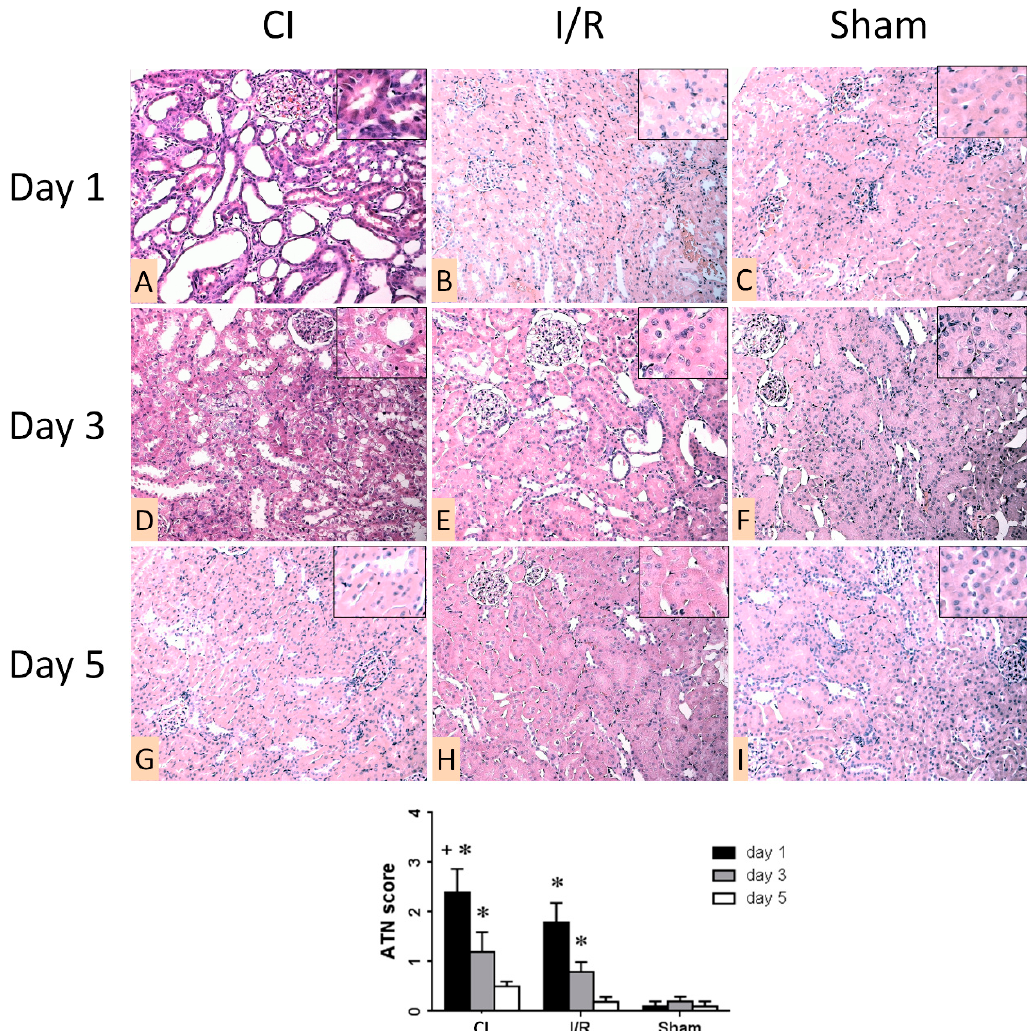
Figure 2. Representative morphologic images of operated left kidneys one ( A – C ), three ( D – F ), and five ( G – I ) days after the operation. First column ( A , D , G ): cold ischemia (CI). Second column ( B , E , H ): ischemia-reperfusion (I/R). Third column ( C , F , I ): sham. (hematoxylin–eosin (HE) staining, 200 × ). Inserts show proximal tubular damage (1000 × ). Graph: quantitative evaluation of acute tubular necrosis (ATN) score 1, 3 and 5 days after the operation (n = 8 in all groups). *: p < 0.01 vs. sham, +: p < 0.05 vs. I/R (day 1). (HE staining, 200 × ).